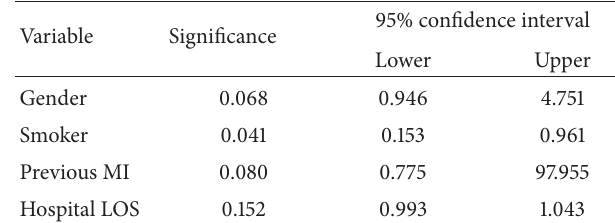
Table 3: Multivariate analysis ( 𝑃 value) of risk factors related to MDRO infection.